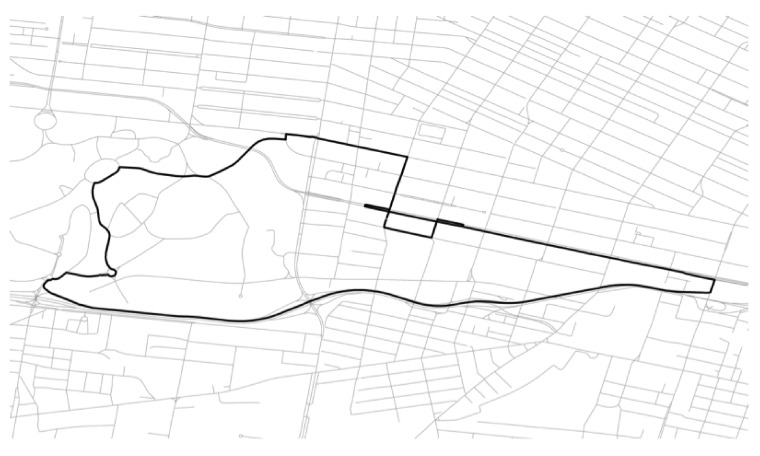
1 minute AM routes.